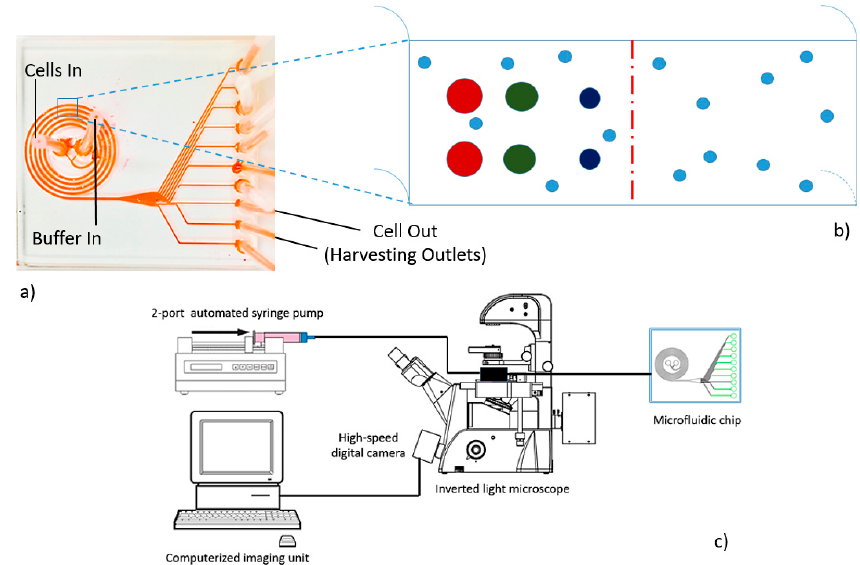
Figure 2. The configuration of the predesigned Archimedean spiral microchannel used in this study. ( a ) The outward appearance of the microdevice consisting of two symmetrical inlets (for cells and buffer, respectively) and a port of ten asymmetrical outlets for sorted cell collections. ( b ) The cross-sectional outline of the curved rectangle microchannel exhibits the predicted lateral displacements of MCT cell focusing in the spiral microchannel. ( c ) The instrumentation diagram of the sorting system employed in this study. The system is mainly composed of a two-port automatic syringe pump, an inverted light microscope connected to a high-speed digital camera, and a computerized imaging unit.